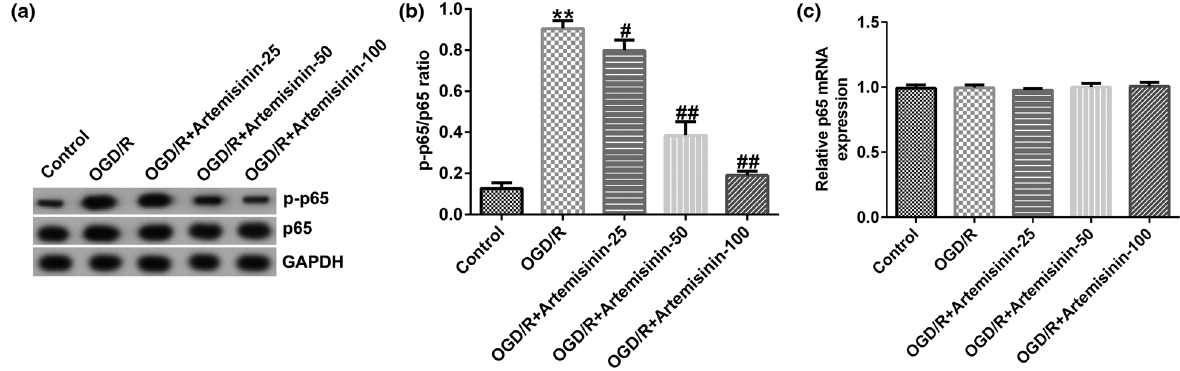
Figure 5: ART inhibits the activation of NF - κ B signaling pathway in OGD/R - induced SH - SY5Y cells. SH - SY5Y cells were pre - treated with the indicated concentrations of ART ( 0, 25, 50, and 100 μ M ) for 2 h and then exposed to OGD/R. ( a ) Protein expressions of p - p65 and p65 were measured using western blotting. ( b ) p - p65/p65 ratio. ( c ) mRNA expression of p65 was determined via RT - qPCR. ** p < 0.01 vs Control; #,## p < 0.05, 0.01 vs OGD/R.